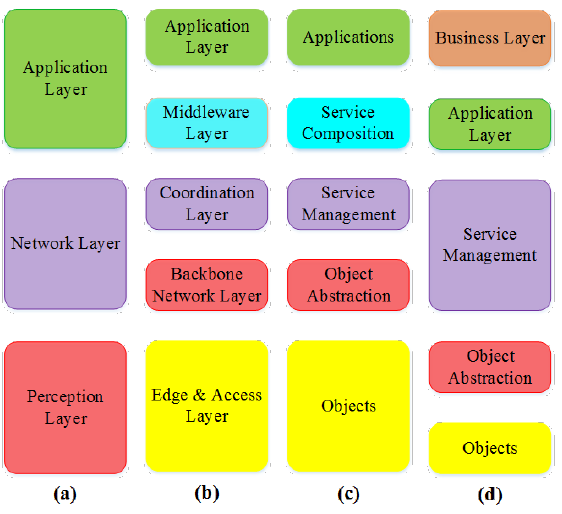
Figure 9. ( a ) Three-Layer Architecture. ( b ) Middle-Ware-Based Architecture. ( c ) Service-Oriented Architecture Based Model. ( d ) Five-Layer